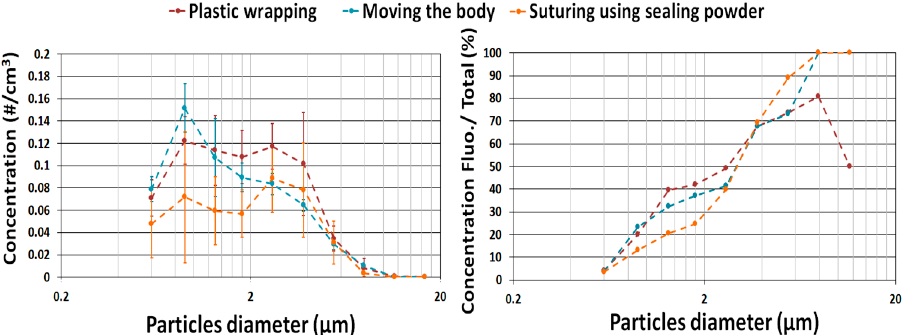
Figure 6. Fluorescent particle concentration ( left ) and fluorescent fraction ( right ) by particle size for the three most emissive tasks observed in lab B.